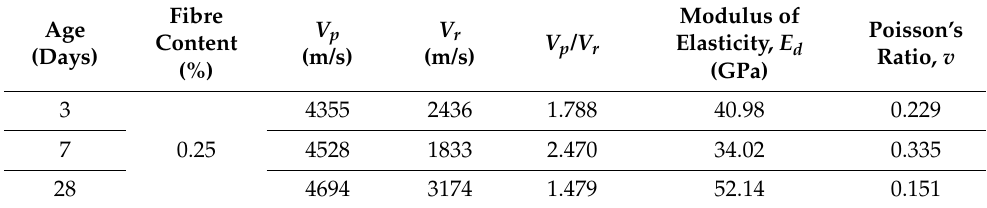
Table 11. Modulus and Poisson’s ratio for beams with 50 mm